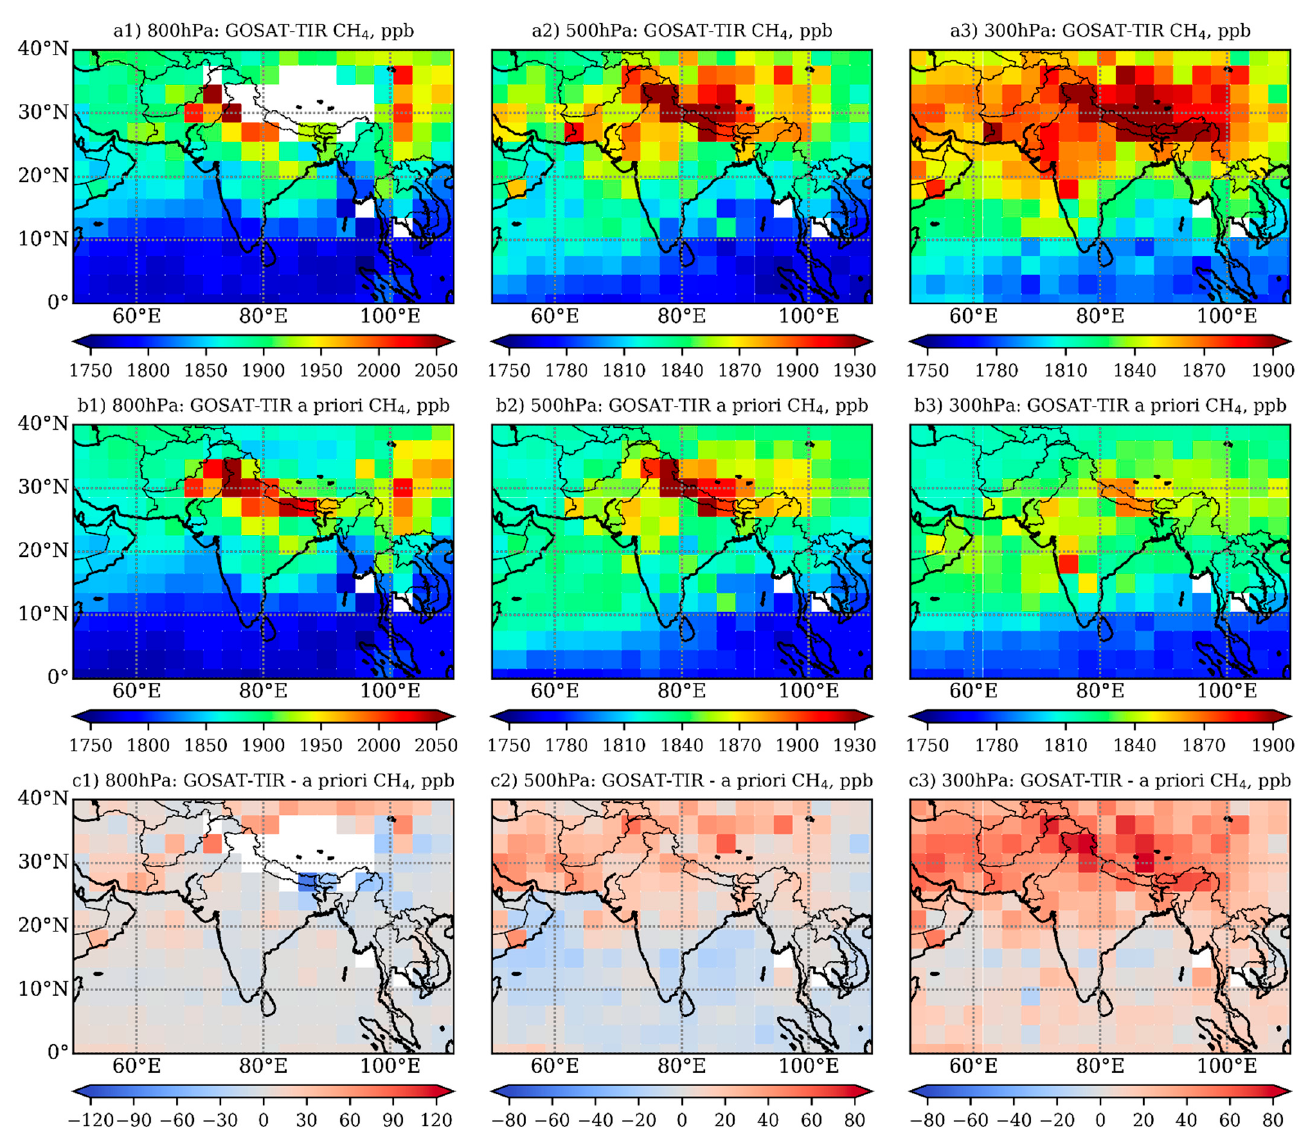
Figure 5. Latitude–longitude distributions of CH 4 at the levels of 800, 500, and 300 hPa (the left, middle, and right panels, respectively) observed by GOSAT-TIR for the season AMJ 2011. The top ( a1 – a3 ), middle ( b1 – b3 ) and bottom ( c1 – c3 ) rows show TIR CH 4 , TIR CH 4 a priori, and difference between the TIR CH 4 and a priori distributions, respectively.